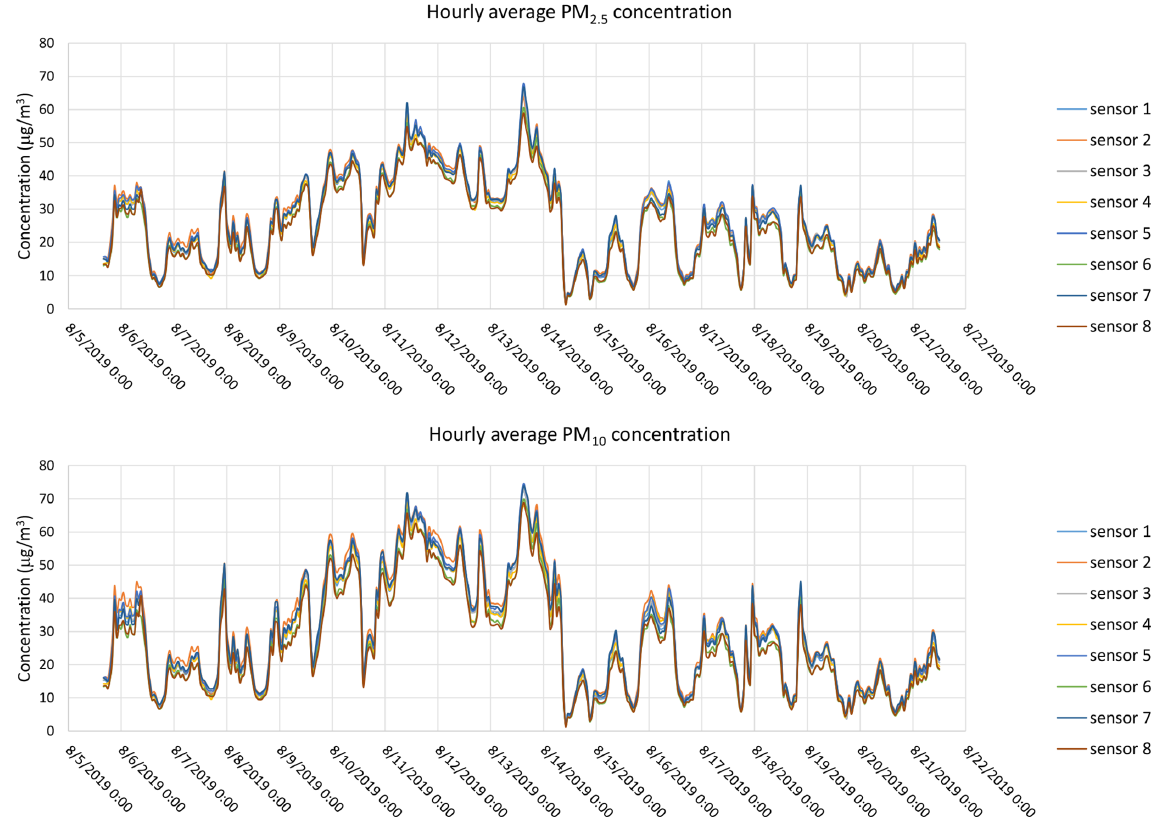
Figure 3. Preliminary test of eight MAQS sensors, outdoor